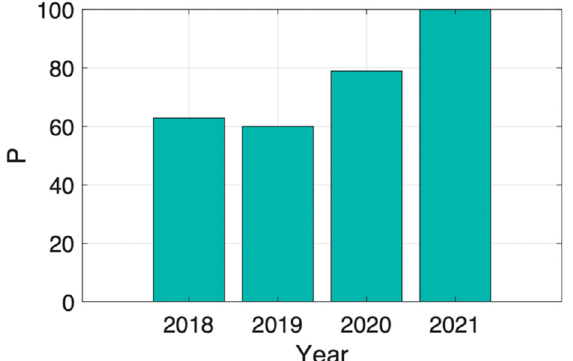
Figure 2. Performance (total score) for the development of each year.